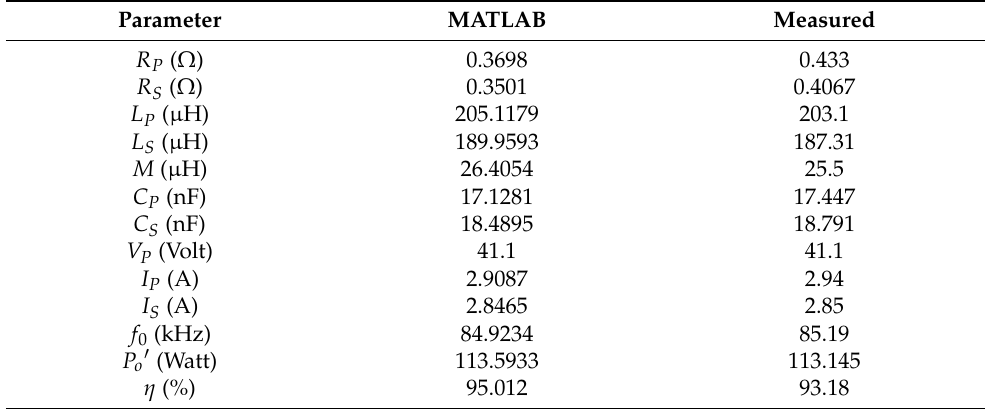
Table 1. Design parameters of the optimum